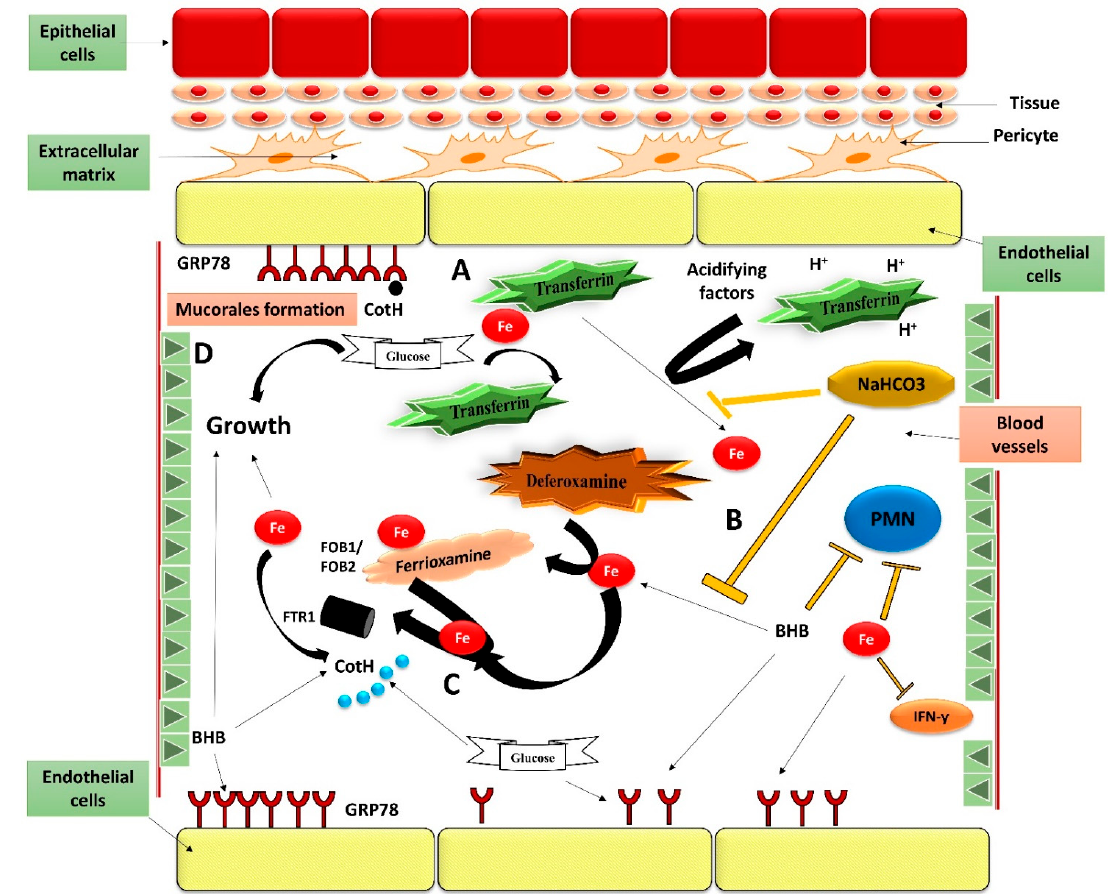
Figure 6. Interaction between Mucorales and endothelial cells during hematogenous proliferation, as well as the influence of host attributes on these relationships and the immune response. ( A )—Through glycosylation and protonation, hyper- glycemia and ketoacidosis trigger the production of Fe from transferrin.; ( B )—Immunological response to disease is harmed by BHB and free Fe, but at the other end, NaHCO3 counteracts this damaging activity by decreasing transferrin iron release and mitigating acidity.; ( C )—GRP78 expression on vascular endothelium significantly increased in response to the stressors caused by free Fe, hyperglycemia and ketone substances.; ( D )—Free Fe, glucose and BHB increase the production of CotH in fungal cells, resulting in endothelium invasion and increased fungal